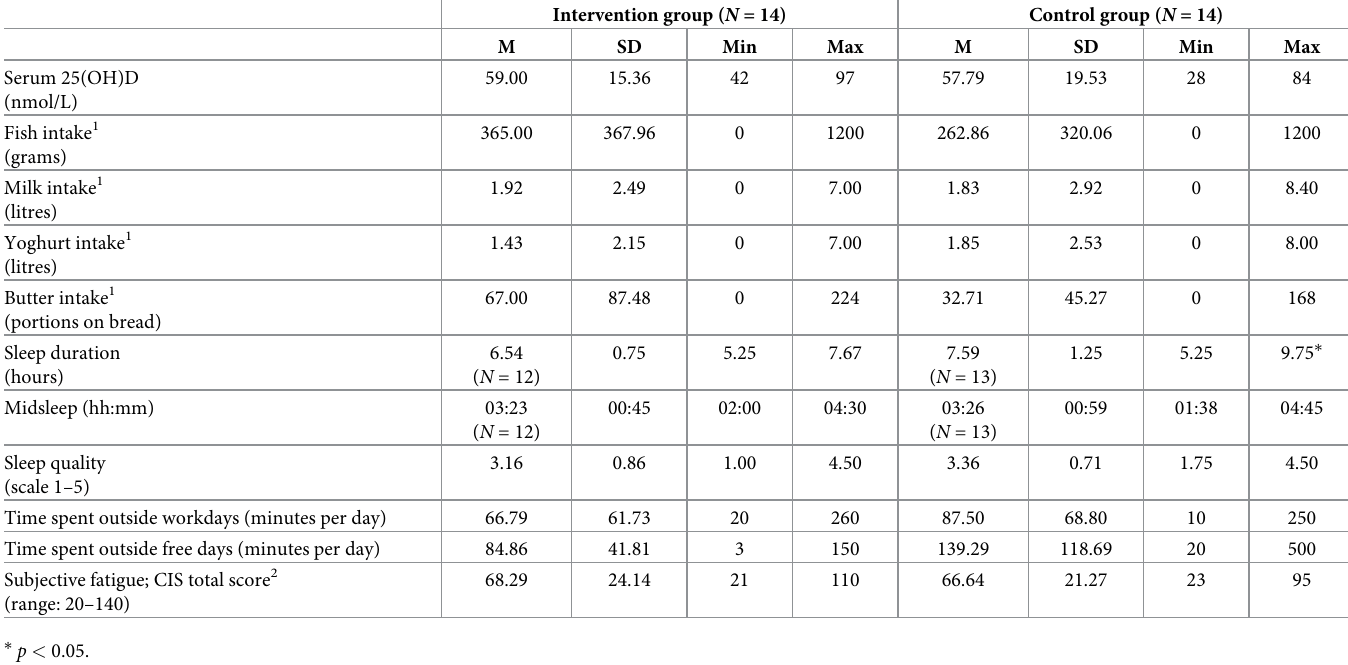
Table 3. Descriptive statistics of all variables measured at